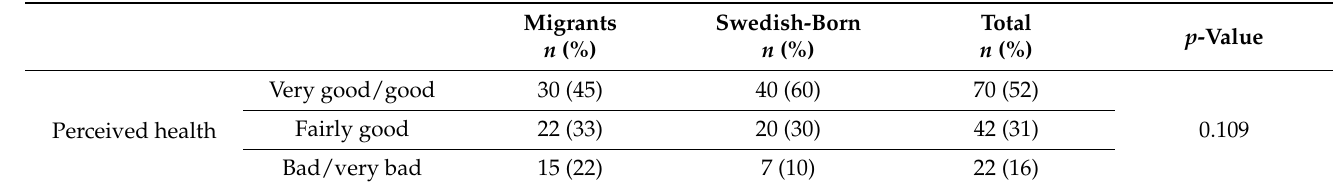
Table 3. Perceived health among migrants and Swedish-born persons with type 2 diabetes living in Sweden.